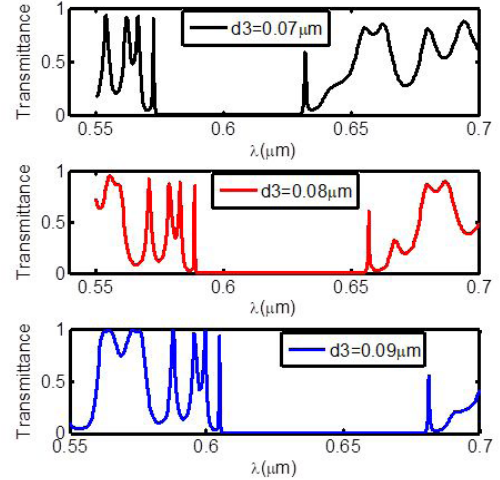
Figure 6. Transmittance spectra simulated on the quasi-periodic 1D PC structure with d3 varied to be 0.07, 0.08, and 0.09 µm while d2 is fixed to be at